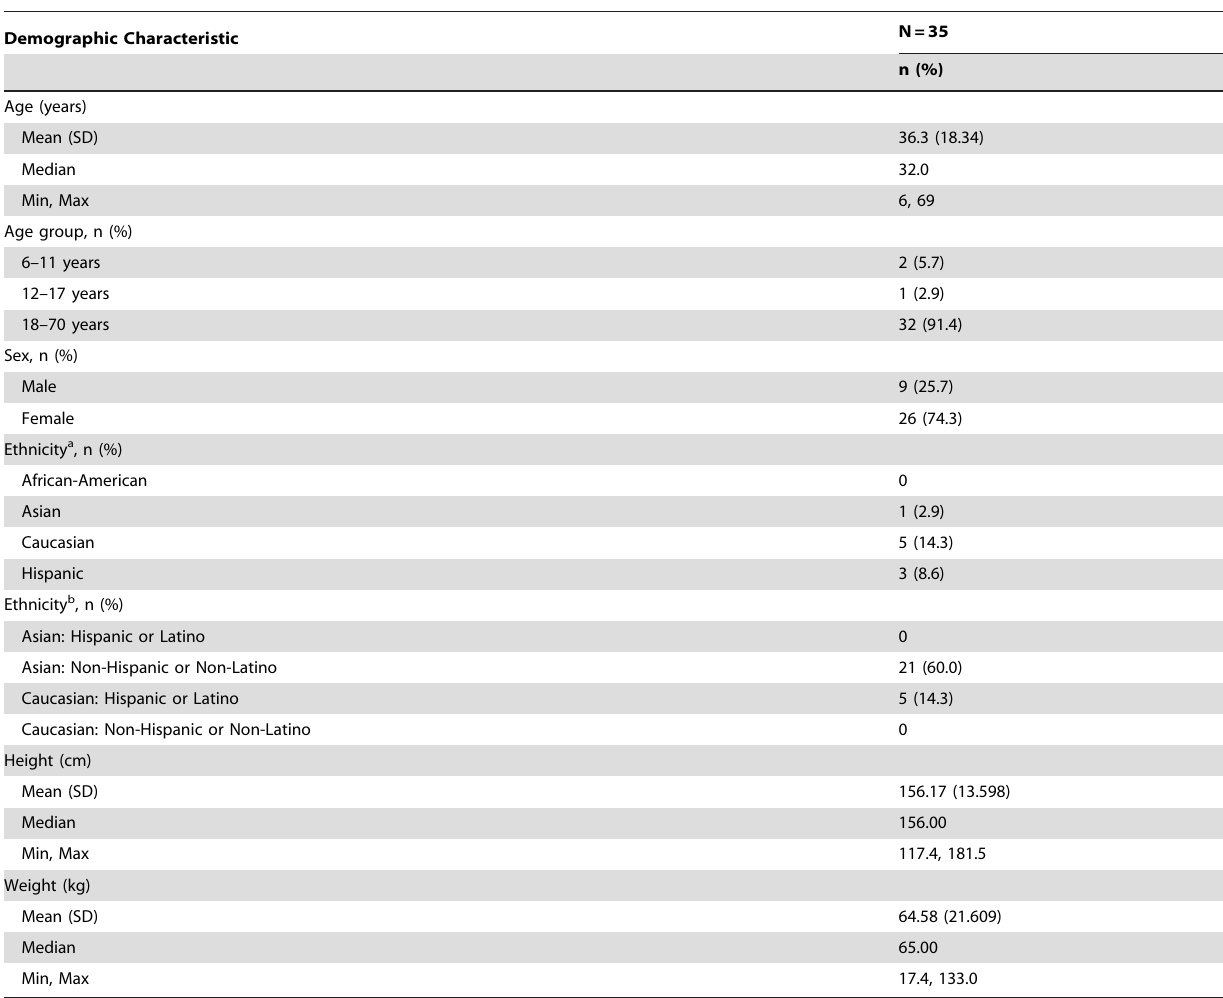
Table 1. Patients